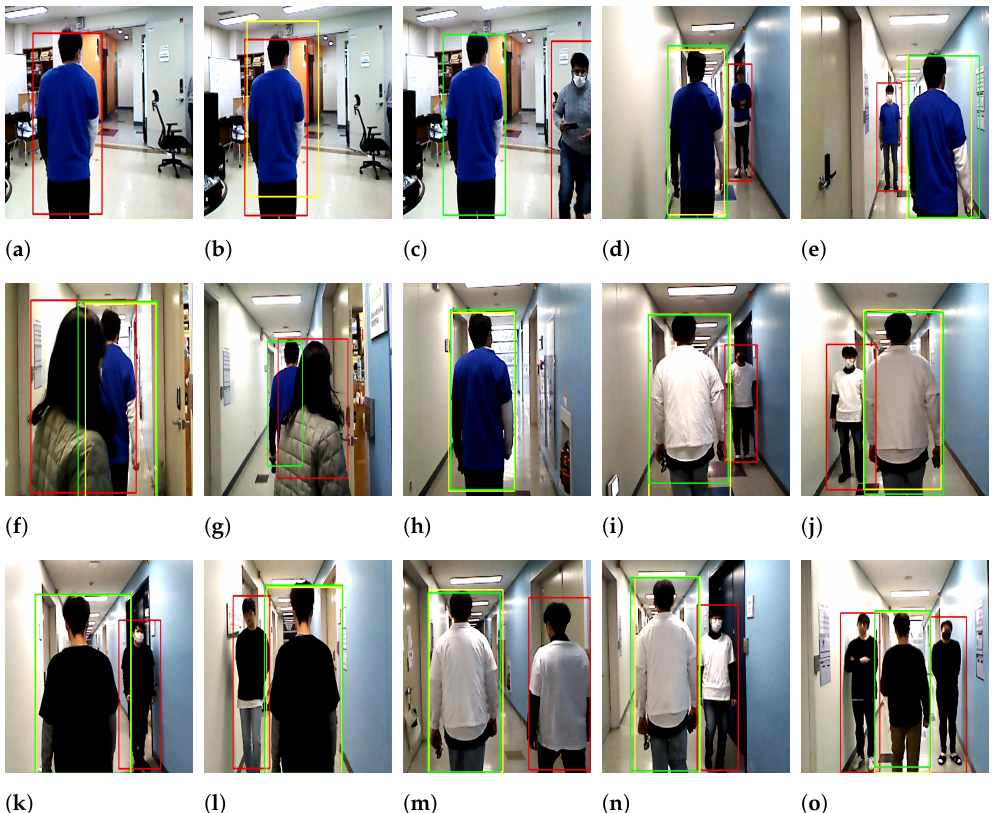
Figure 15. Snapshots of the experiments for three target persons with three different colors: robot’s